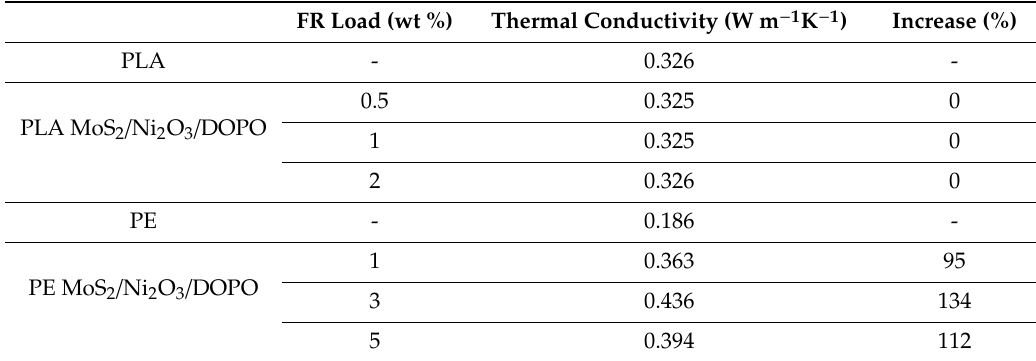
Table 3. Thermal conductivity of PE and PLA composites compared to pristine